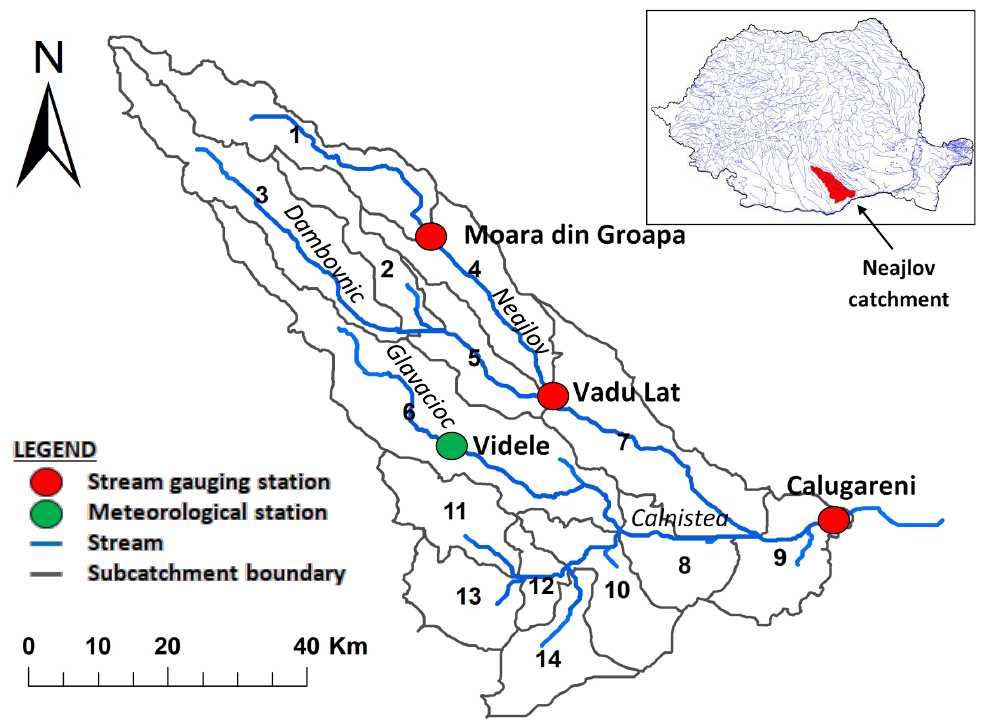
Figure 1. Neajlov River main tributaries, subcatchments (1–14), including stream and meteorological monitoring stations. Inset: Location of Neajlov catchment in Romania.